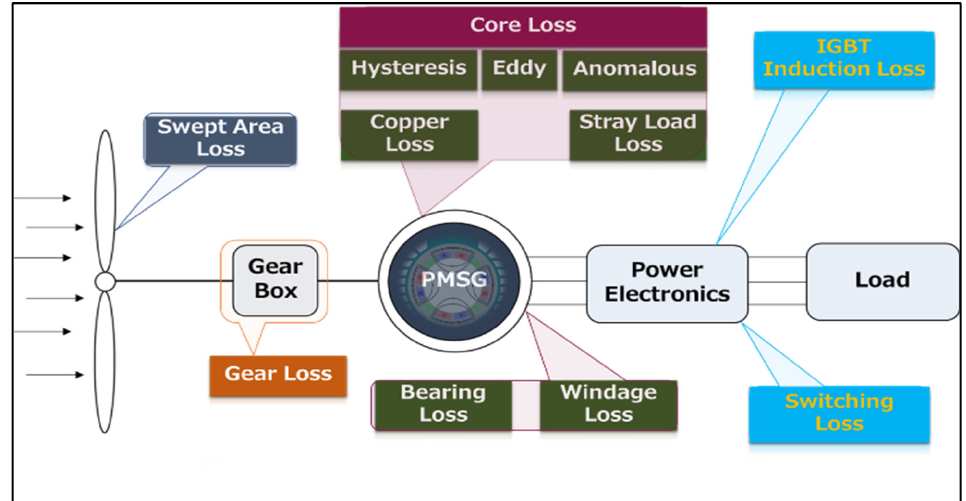
Figure 1. Wind turbine power train and types of distributed losses.